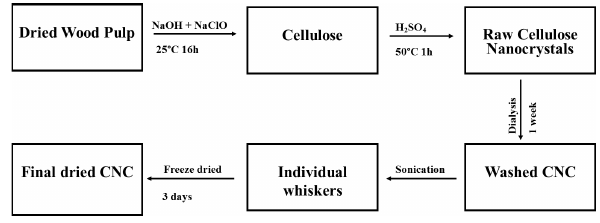
Figure 3: Typical procedure for producing CNC